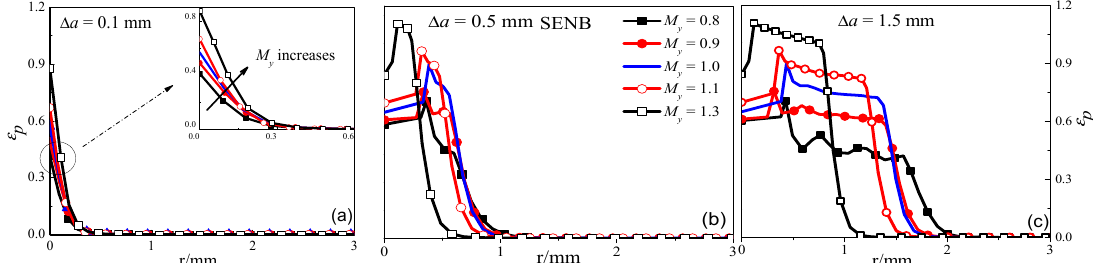
Figure 6. Equivalent plastic strain distributions ahead of the current crack tip for all the mismatched SENB specimens, ( a ) ∆ a = 0.1 mm; ( b ) ∆ a = 0.5 mm; and, ( c ) ∆ a = 1.5 mm.